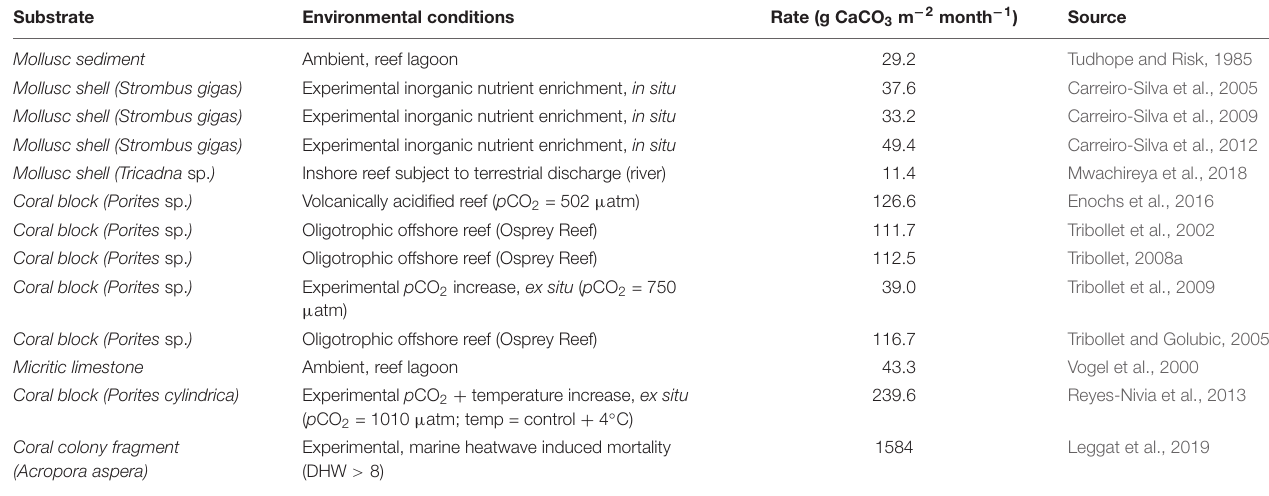
TABLE 5 | Maximum rates of microbioerosion reported in the literature, in different substrates and under a variety of environmental or experimental conditions (Leggat et al., 2019). Substrate